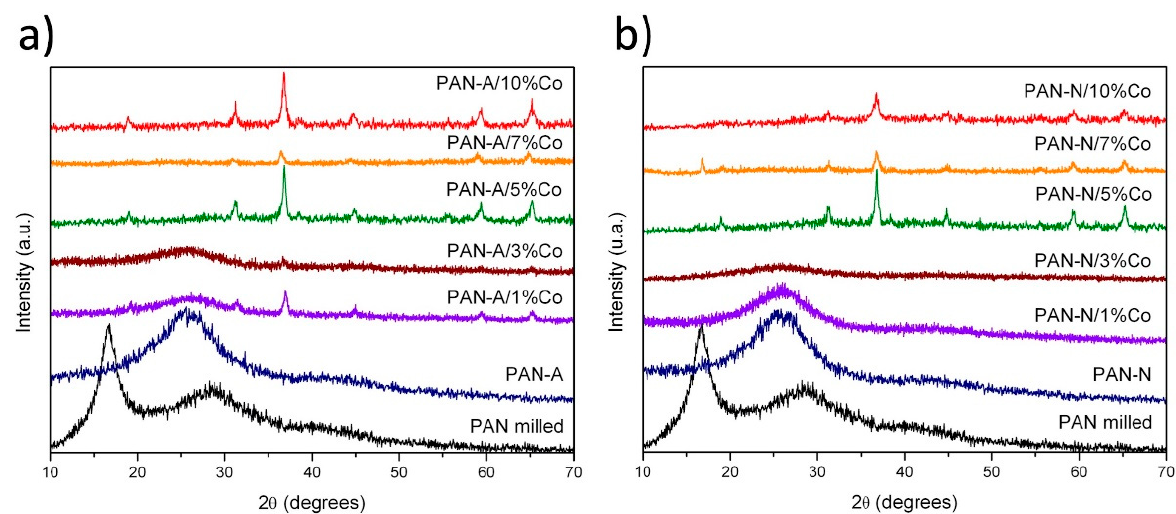
Figure 1. XRD patterns of Co-N-carbon at different Co loading and thermal treatment under air ( a ) and N 2 ( b ) atmospheres, respectively.